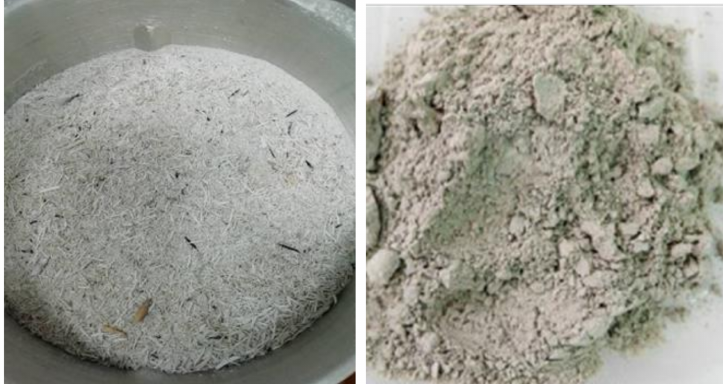
Figure 1. Images of rice husk ash (RHA) before ( left ) and after ( right ) grinding. The fine structure of RHA before and after grinding viewed under a scanning electron microscope (SEM) is shown in Figure 2. The RHA particle size before grinding ranges from 1 to 100 µ m. Particles appear as plates and thin shell-like structures with rectangular indents on the surface. These forms constitute the initial structure of the RH.